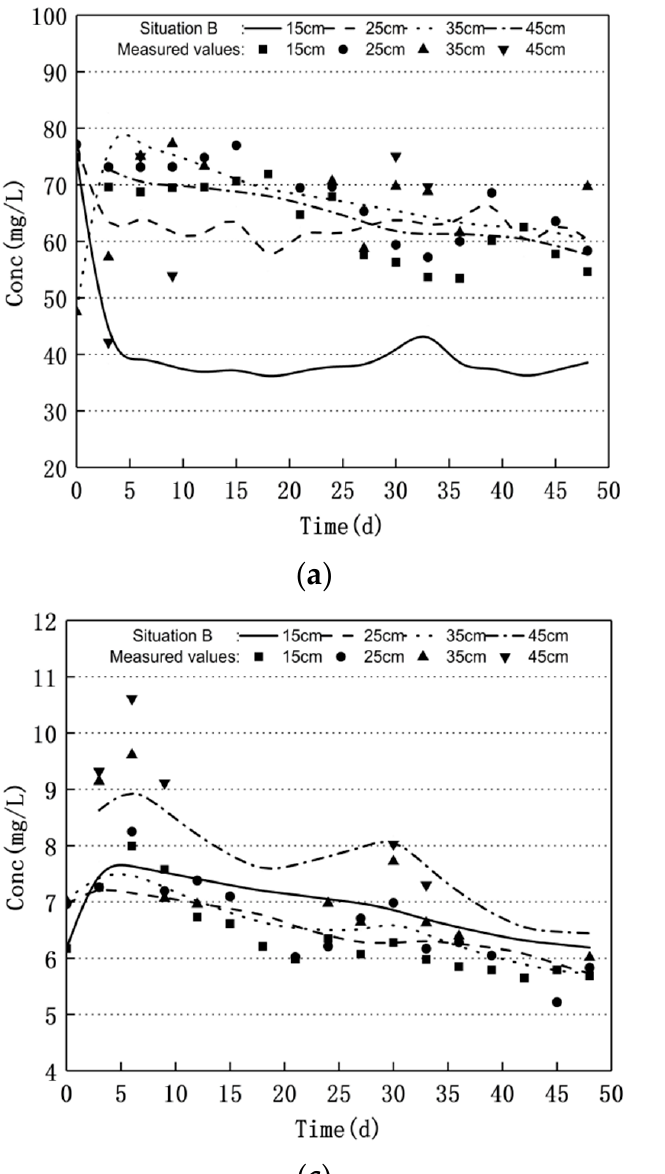
Figure 12. The measured results of coarse sand and the process of dynamic change of nitrogen in situation B (( a ) nitrate nitrogen; ( b ) nitrite nitrogen; ( c ) ammonium nitrogen).